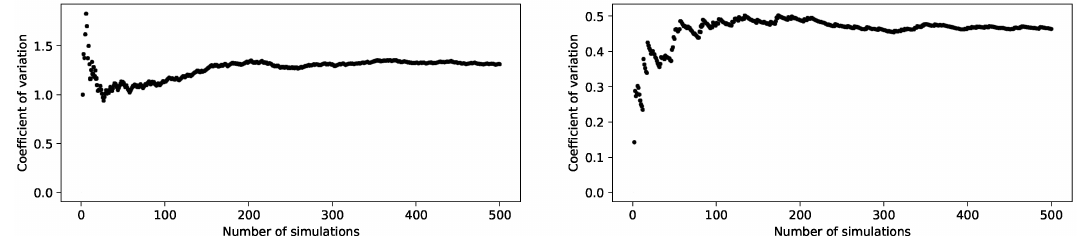
Figure 5. Coefficient of variability varying with the number of simulation runs.